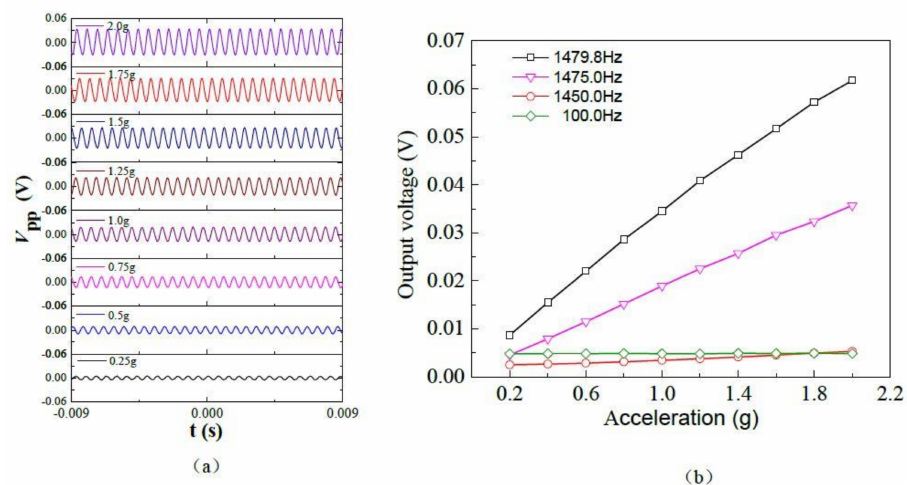
Figure 11. Piezoelectric characteristics curves of the sensor under different accelerations: ( a ) the output voltage waveforms of piezoelectric response; ( b ) the relationship curves between output voltage and a .